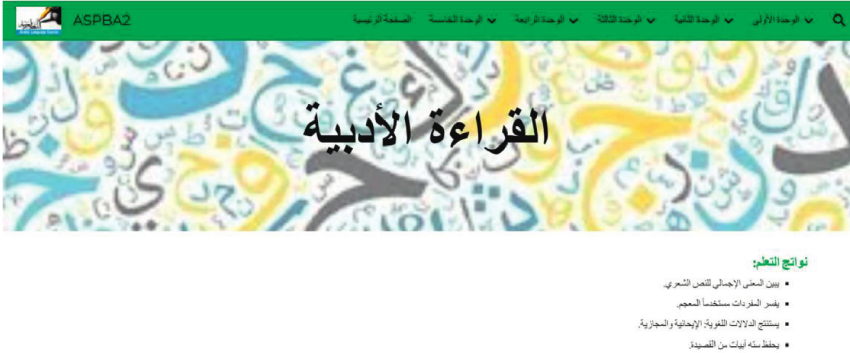
Figure 5: Learning outcomes of a reading lesson about Nelson Mandela